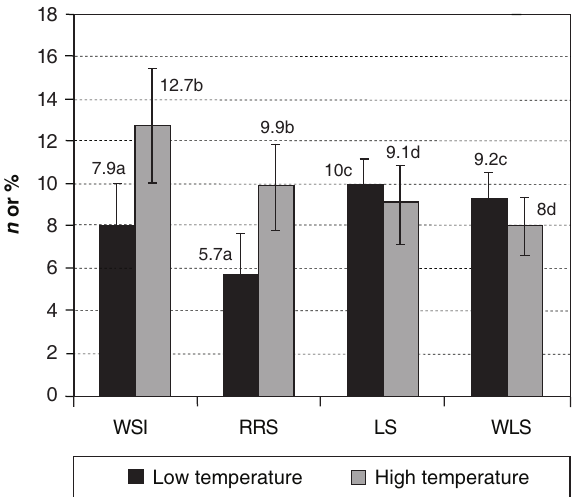
The effects of season on the sows reproductive per- formance in Kenyan pig breeding